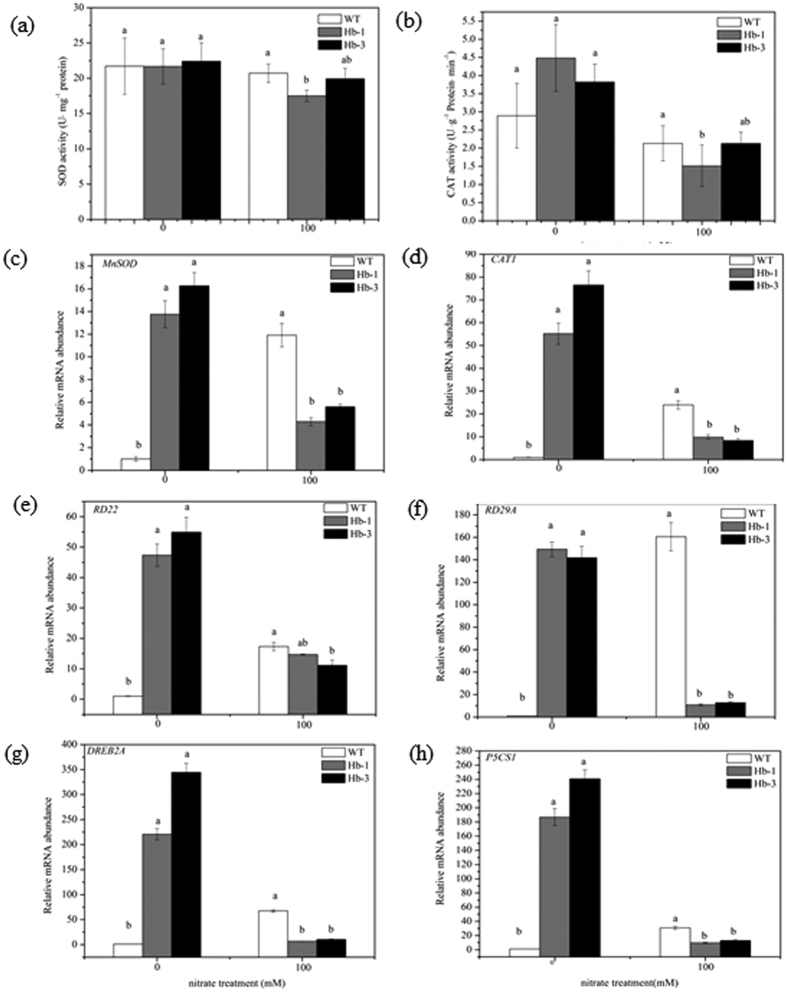
The physiological and molecular response of SoHb transgenic plants to nitrate stress.(a–d) The antioxidant enzyme activities and relative transcript levels of SOD and CAT of WT and transgenic plants. (e–h) The expression of stress-induced genes of RD22, RD29A, DREB2A, and P5CS1 in WT and transgenic plants assayed by qRT-PCR. Plants were treated with 100 mM nitrate solution for 15 days. The experiment was replicated three times with similar results. Means denoted by different letters show significant differences at P < 0.05 according to Duncan test.